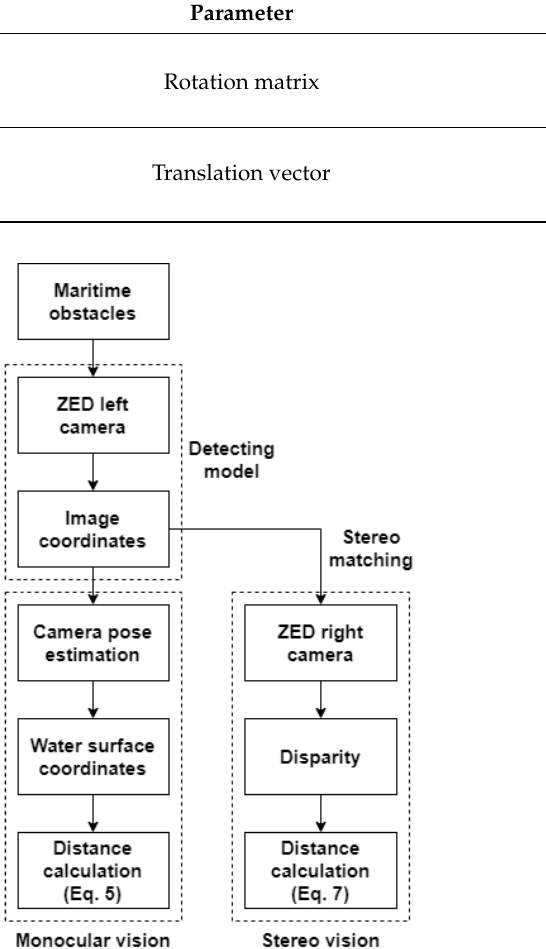
Table 6. Camera extrinsic parameter information by solvePnP.